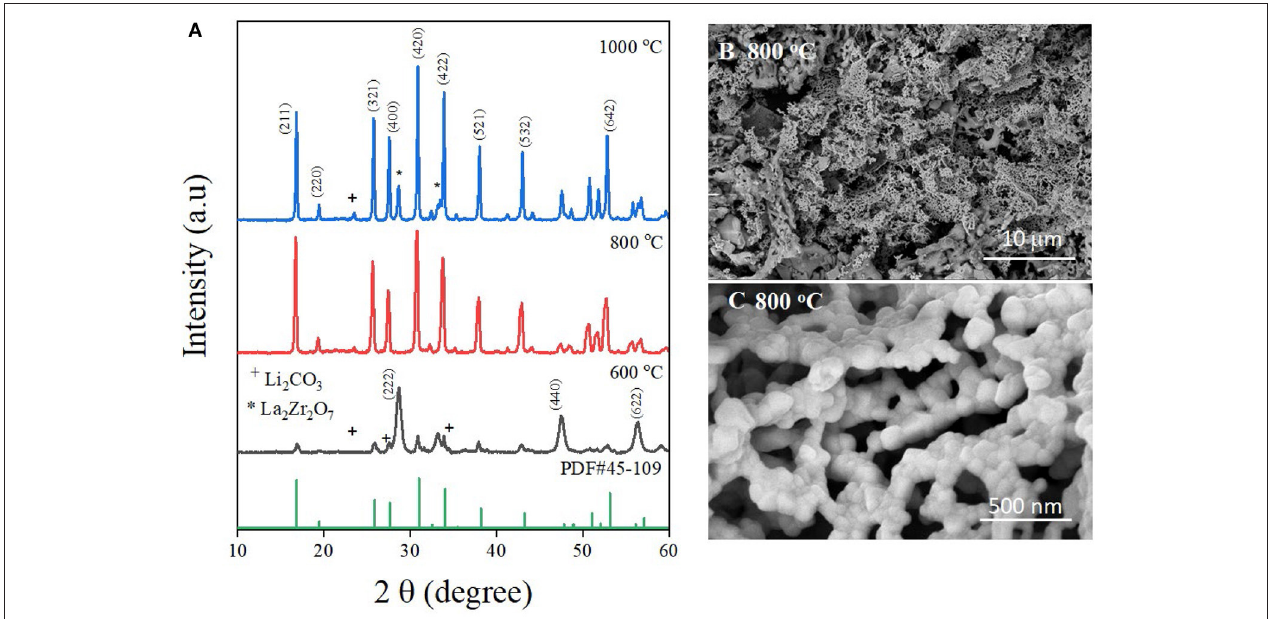
FIGURE 1 | (A) Comparison of X-ray diffraction patterns of LLZO synthesized at various temperatures. SEM images of LLZO nanoparticles synthesized at 800 ◦ C at (B) low magnification, and (C) high magnification.